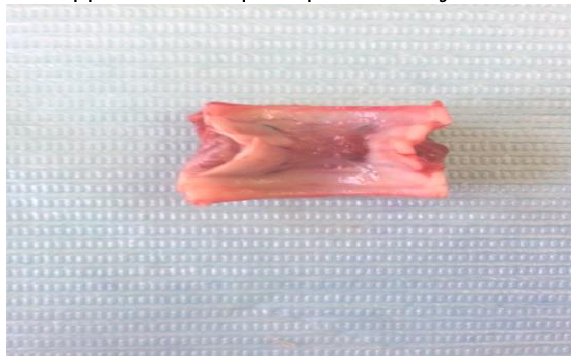
Figure, 10: Shows tracheal defect of dog was still appeared also at 30 postoperative day in G2.